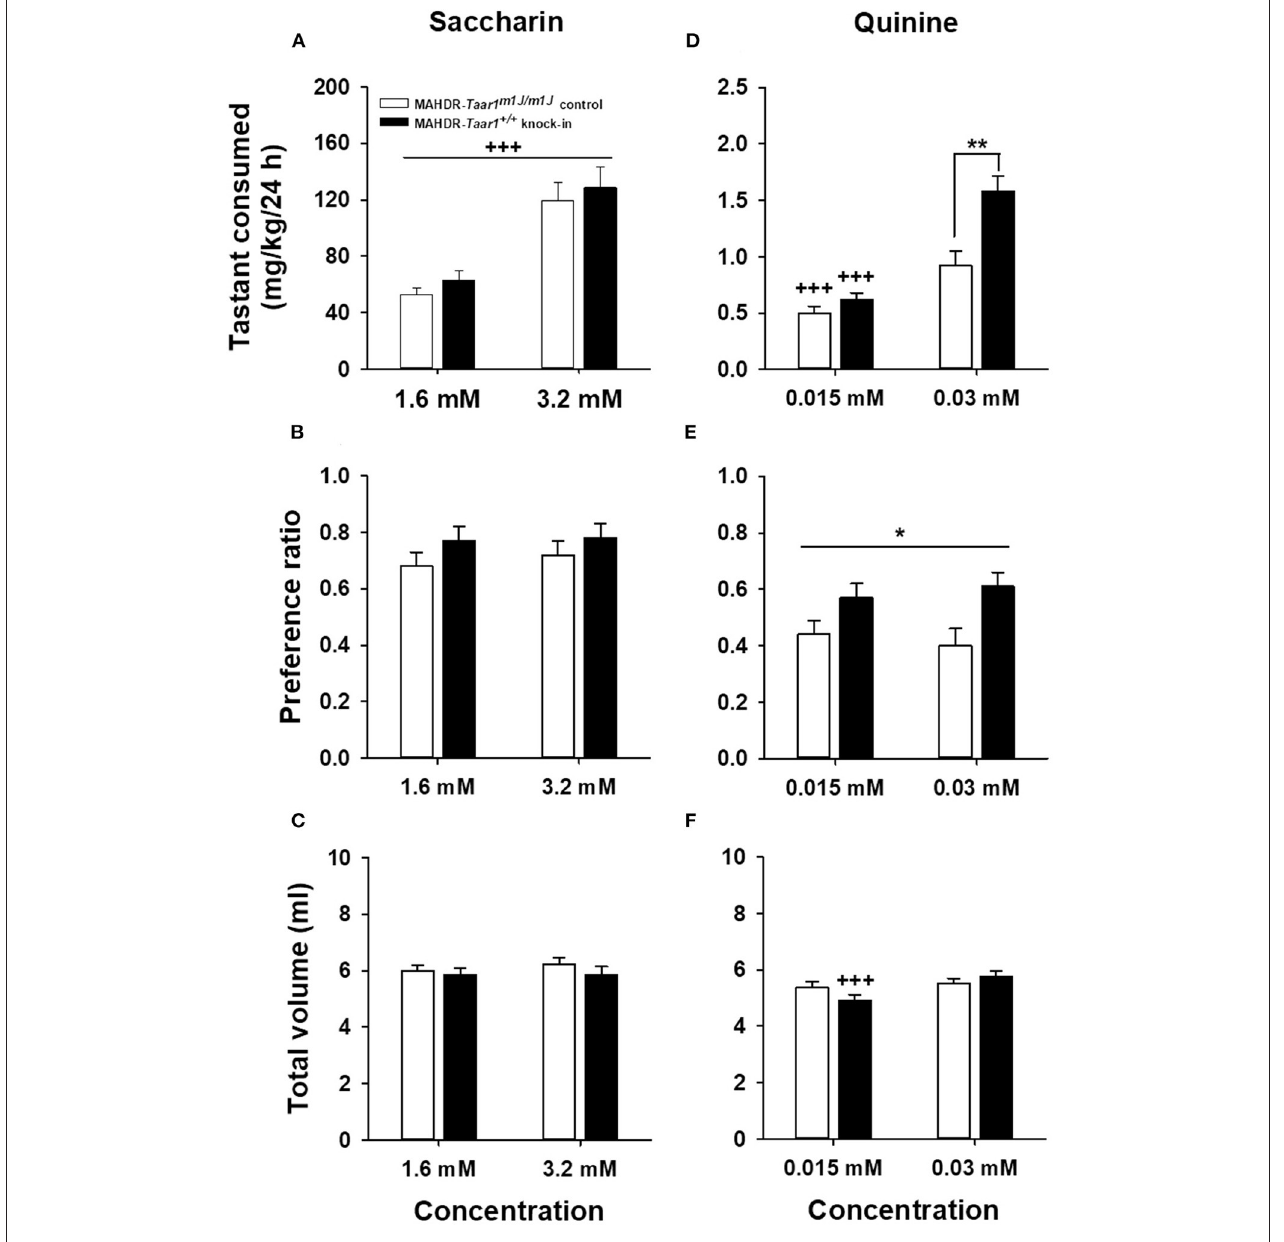
FIGURE 1 | Novel saccharin and quinine tastant intake and preference in MAHDR- Taar1 + / + KI and MAHDR- Taar1 m 1 J / m 1 J control mice. Shown are means ± SEM for (A) saccharin consumed (mg/kg/24h), (B) saccharin preference ratio (ml from saccharin tube/total ml consumed), (C) total volume (ml/24h) consumed (water + saccharin solution) during access to each saccharin concentration, (D) quinine consumed (mg/kg 24h), (E) quinine preference ratio (ml from quinine tube/total ml consumed), and (F) total volume consumed (water + quinine solution) during quinine access. Tastants were offered vs. water for 4-day periods at increasing concentrations in counterbalanced order. Total N = 48 mice (12 mice per sex for the MAHDR- Taar1 + / + KI; 10 female MAHDR- Taar1 m 1 J / m 1 J control mice, and 14